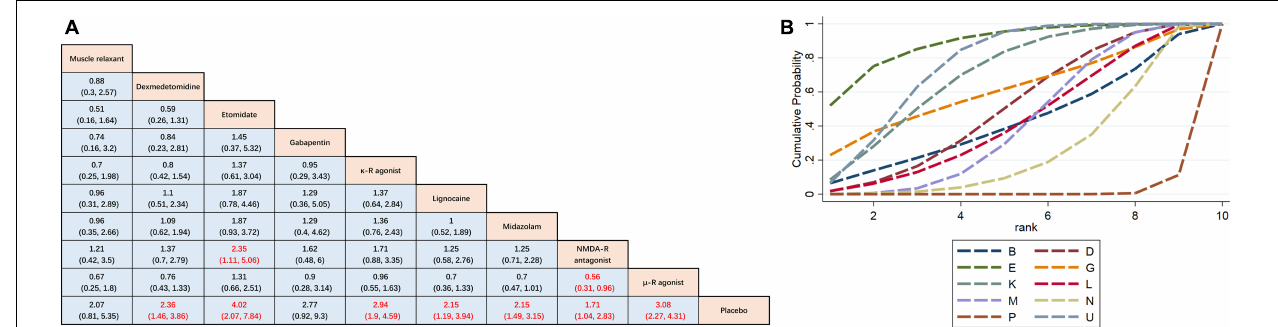
FIGURE 4 | Network meta-analysis comparison. (A) The incidence of etomidate-induced myoclonus was analyzed by using RR and 95%CI. Data in each cell are RR (95%CI) for the comparison of column-defining treatment versus row-defining treatment. Significant results are highlighted in red. RR , risk ratio; CI , confidence interval. (B) Graphical ranking based on SUCRA values (Incidence of total EM). The numbers on the X-axis represent the rankings. As the numbers increases, the effectiveness of the interventions decreases. B muscle relaxant, D dexmedetomidine, E etomidate, G gabapentin, P placebo, K κ opioid receptor agonist, L